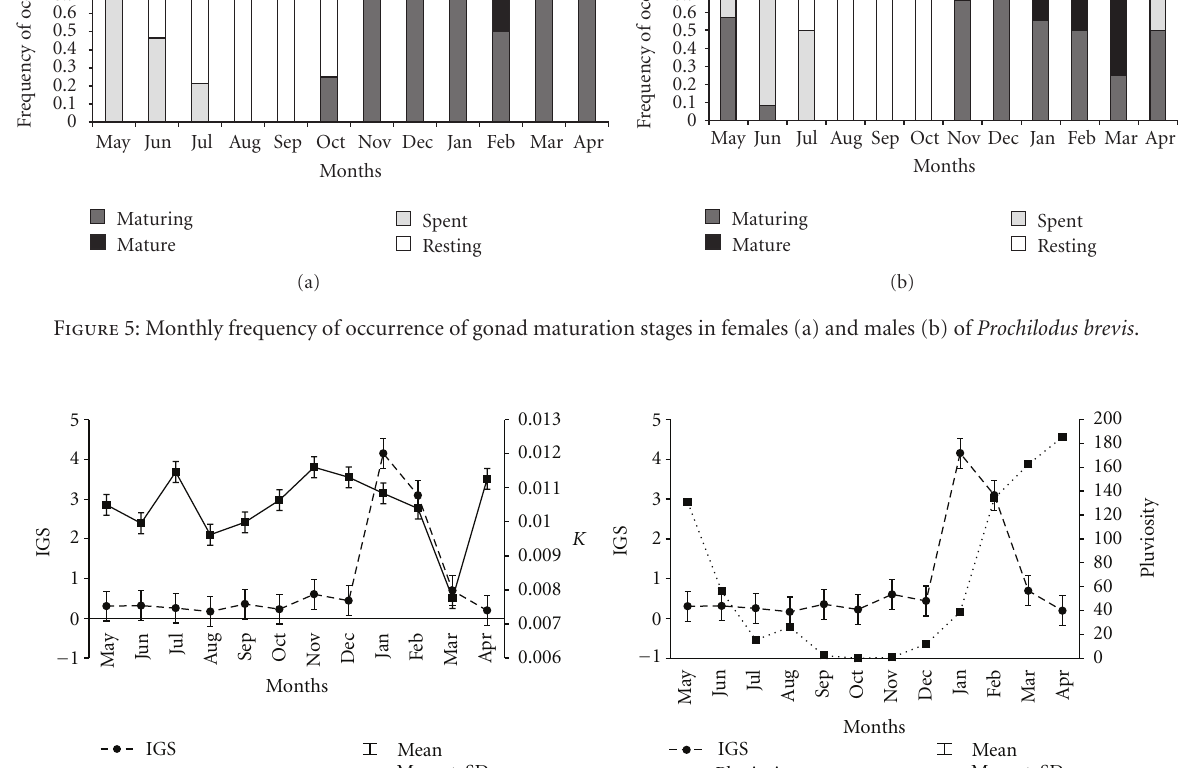
The gonadosomatic index for both sexes in relation to monthly mean rainfall were positively correlated ( r = 0 .